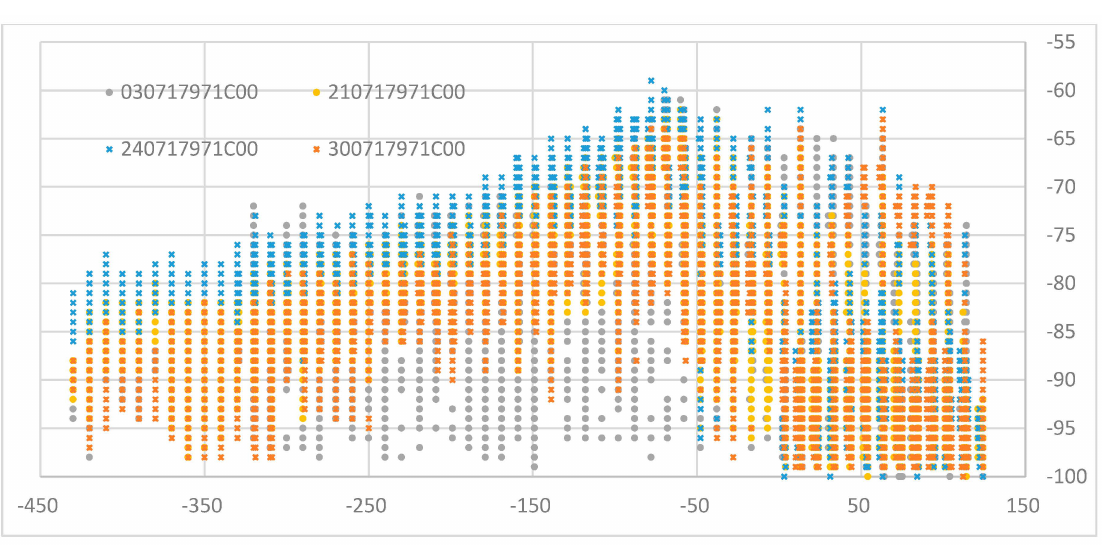
Figure A1. Static experiment test with four BLE Tags on the chest.